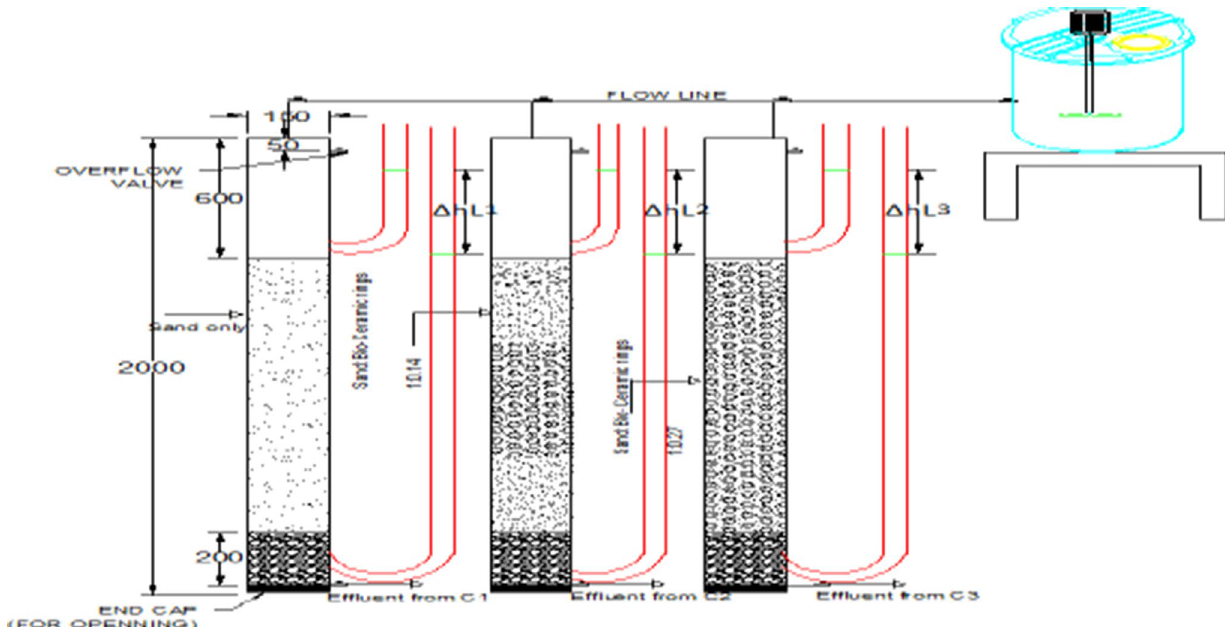
Fig. 14 The experimental setup for run (4) for efficiency mixing ratio between the sand media and ceramic cylinders